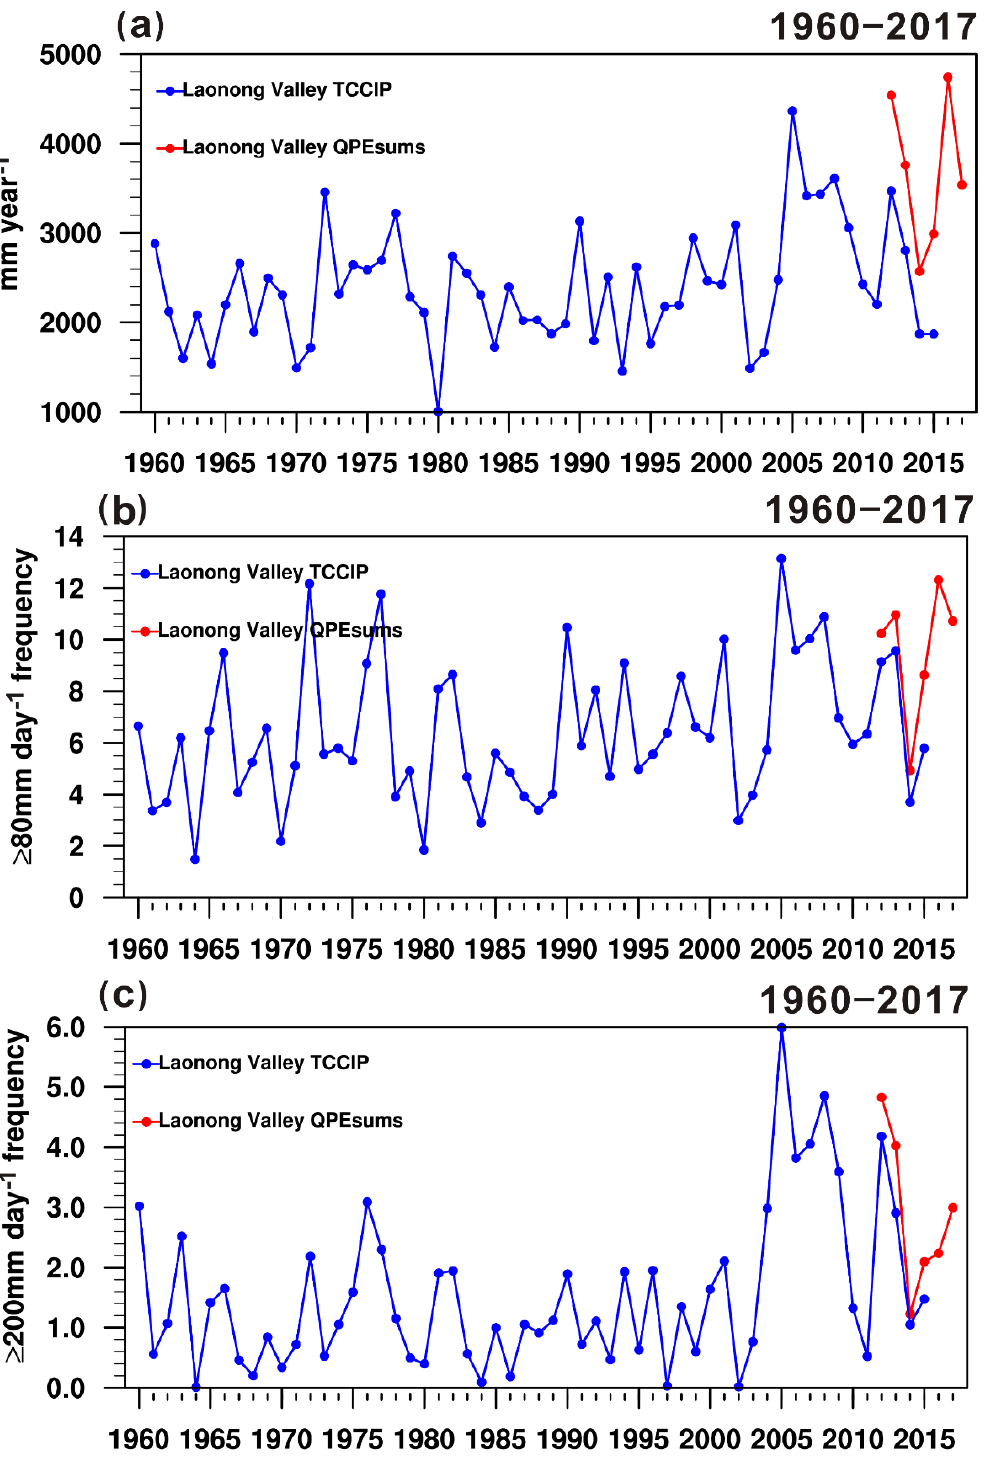
Figure 3. Time series of the frequency of annual rainfall and heavy rain events in the Laonong River watershed: ( a ) annual rainfall, ( b ) events of daily rainfall up to 80 mm, and ( c ) events of daily rainfall up to 200 mm.